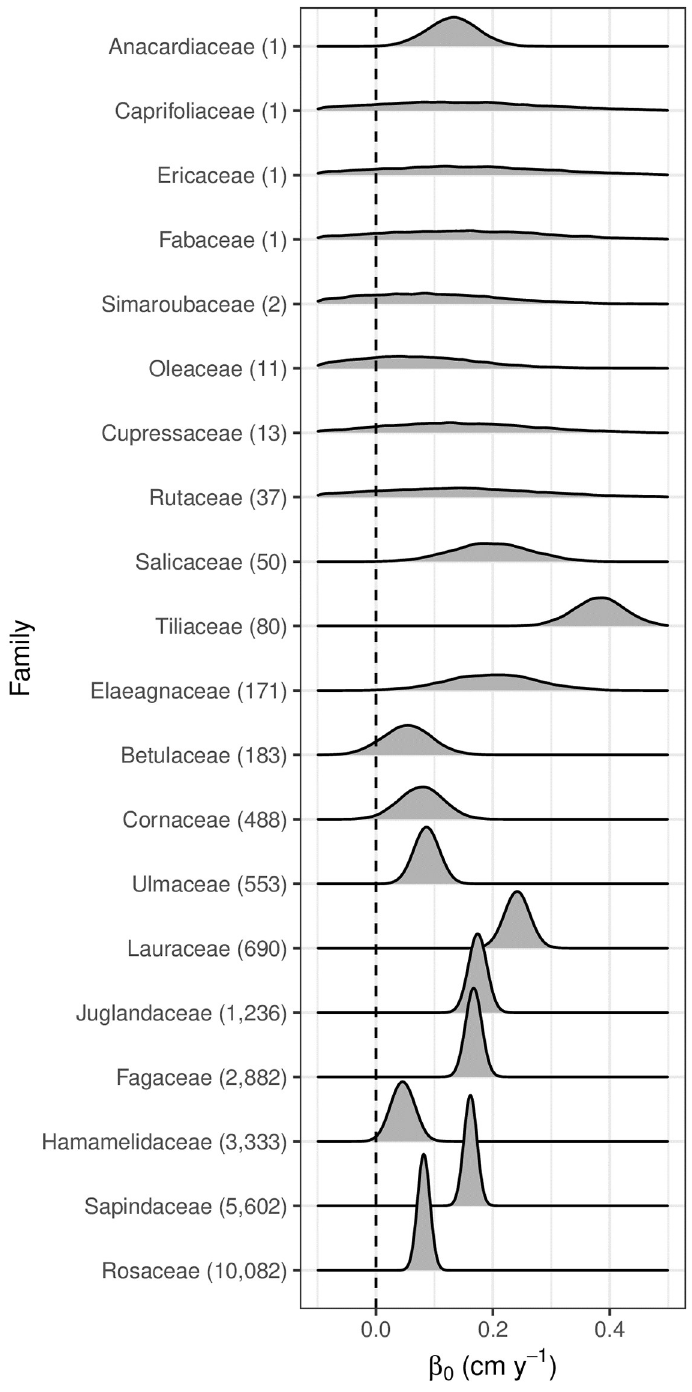
Fig 3. Posterior distribution of β 0, j for the family-level model. These distributions display the estimated baseline (diameter-independent) growth (cm y -1 ) for each family.